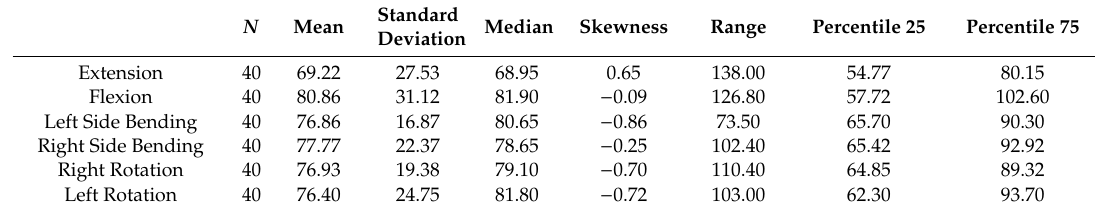
Table 6. Case group normalized values of ROM using AMA guidelines.